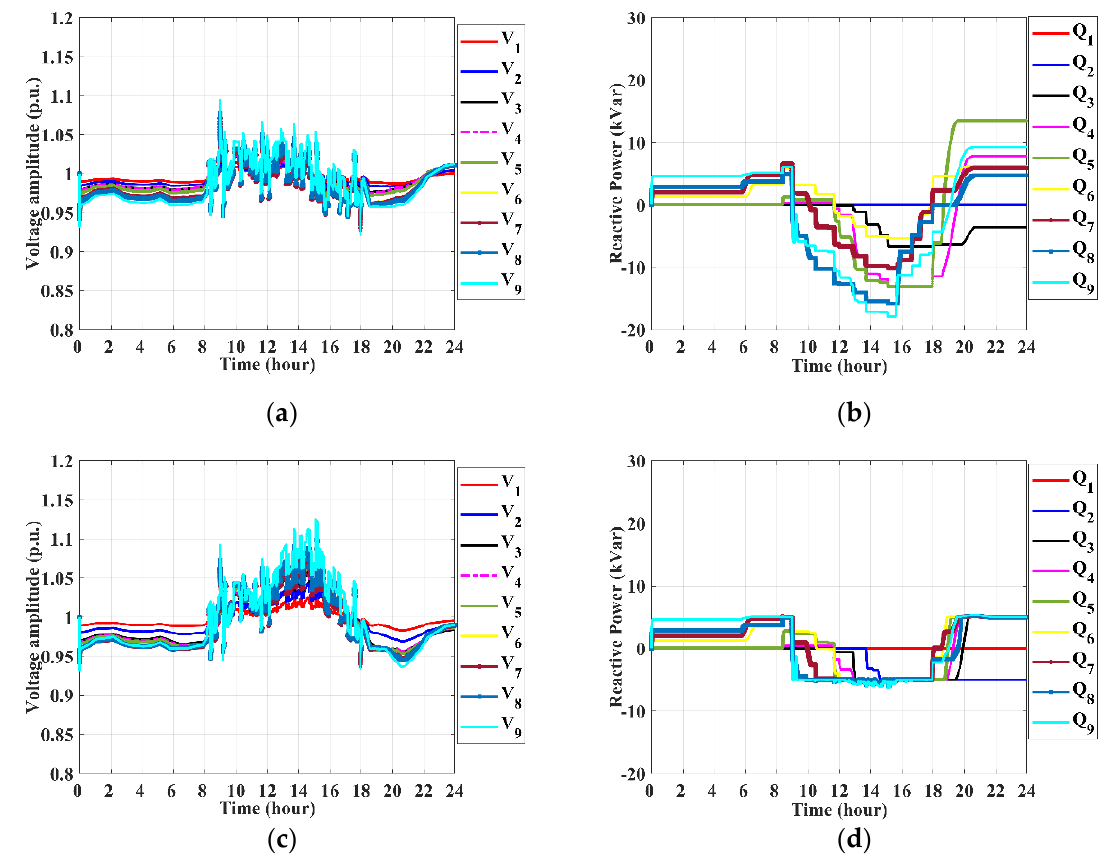
Figure 5. Voltage fluctuations: ( a ) Node voltage fluctuation; ( b ) photovoltaic reactive power output; ( c ) node voltage fluctuation with reactive power limits; ( d ) photovoltaic reactive power output with constraints.